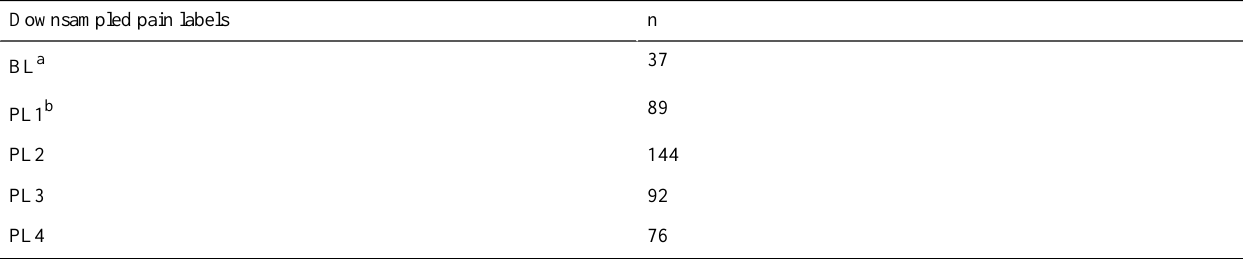
Table 4. Downsampled pain distribution with 5